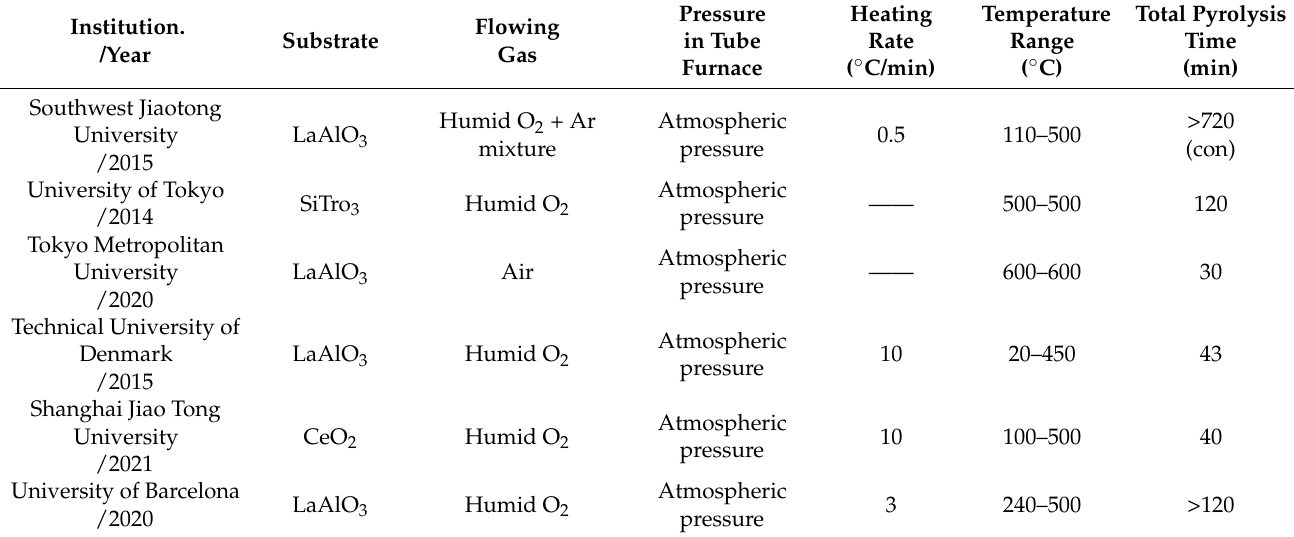
Table 1. Technical characteristics of different research institutions in low-temperature pyrolysis using by